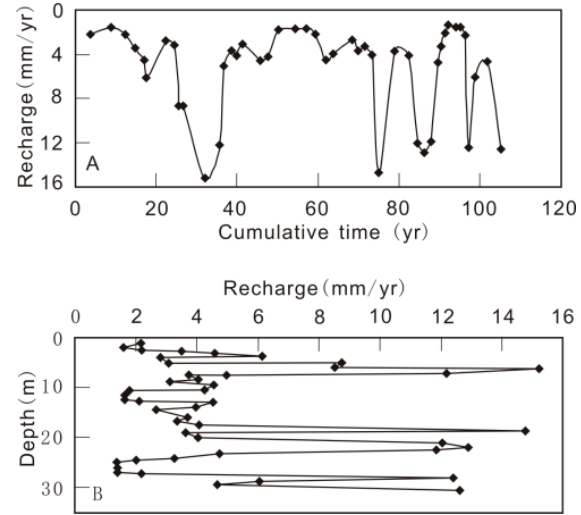
Figure 5. Groundwater recharge at the ZD site.